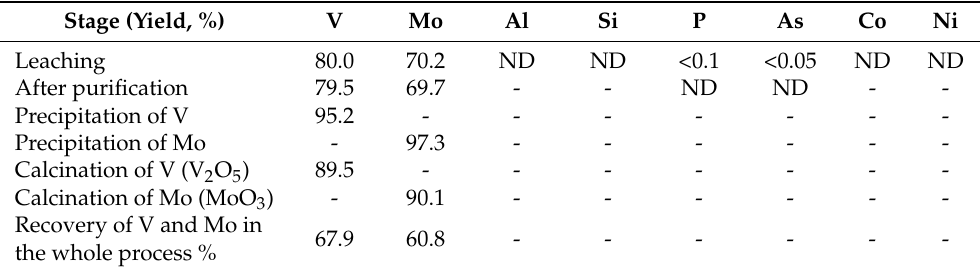
Table 4. Yields of the process